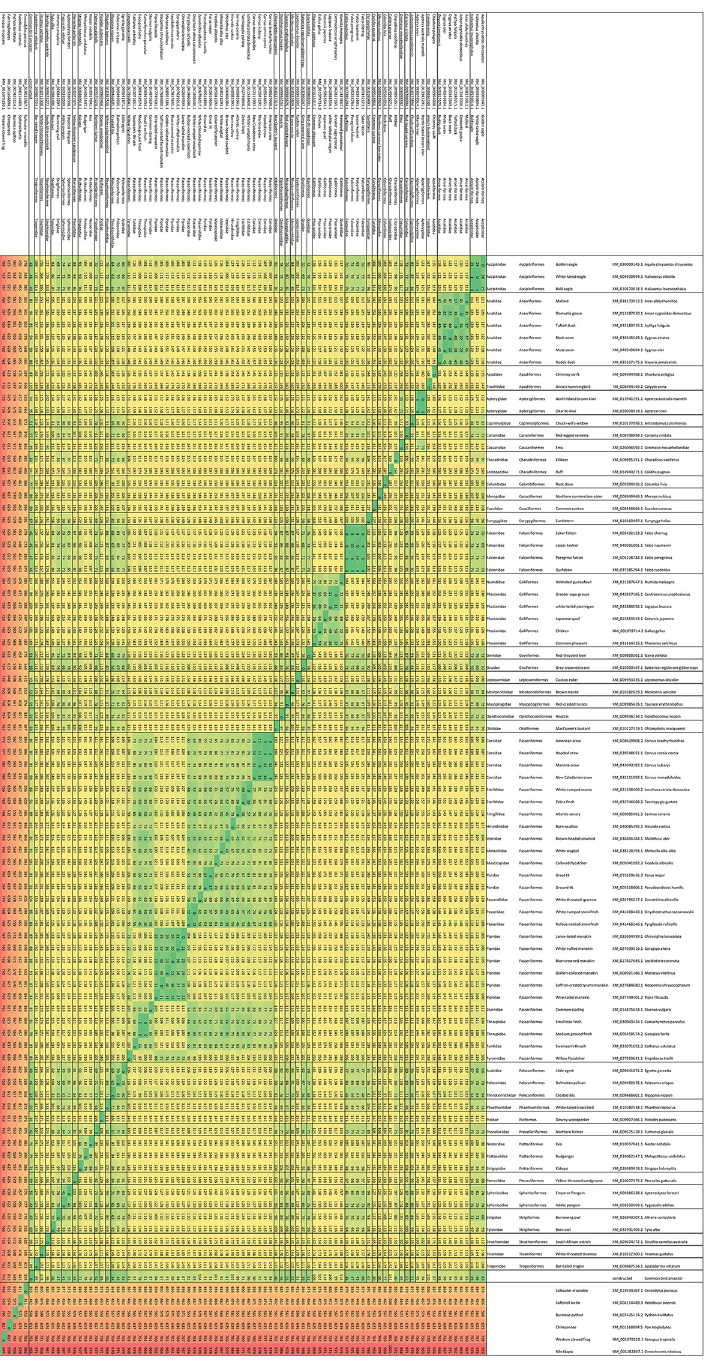
Fig 2. Nucleotide differences between birds and other species. Distance table of 90 compared animal species, including 83 bird species and the constructed common ancestor of birds, with respect to the collagen 1 α 2 GXY domain, indicating, from green via yellow to red, the increasing amount of nucleotide